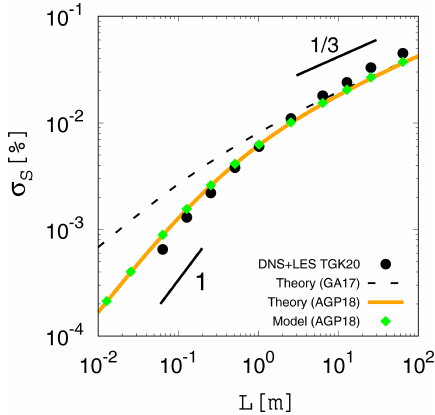
Figure 2. Standard deviation of the supersaturation fluctuation σ S (cid:48) in the statistically steady state obtained from the analytical expres- sion given by Eq. (22) for the second version ( c 1 = c 2 = 1, orange curve) and the results of our numerical integration using the second version given by Eqs. (18) and (19) ( c 1 = c 2 = 1, green diamonds). The dashed line indicates the analytical expression given by Eq. (13) for the original version. The two short black lines indicate slopes of 1 and 1 / 3. The black dots and the axes of the panel are the same as in Fig. 1.